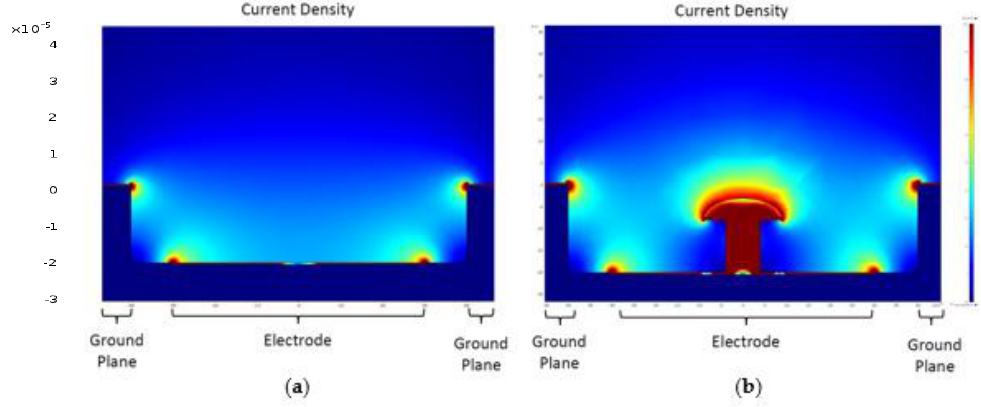
Figure 1. Comparison of the current density delivered by a flat electrode and a protuberant electrode in a two level configuration: ground plane and flat electrode plane are not at the same level—same colour scale.